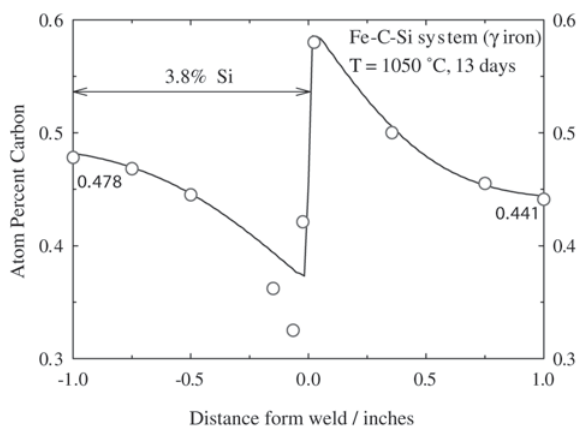
Figure 17. Simulation (solid line) of Darken’s 47 experiment dem- onstrating uphill diffusion of carbon in γ iron at 1050 °C using a jump frequency model for carbon that is a function of the silicon = (16X + 1) 8 × 109, Γ = Γ = 10 6 sec -1 . The concentration, Γ C Si Fe Si open circles represent concentrations from Darken’s experiment. The simulated concentration profile was obtained by multiplying the normalized concentration profile (512 iterations) with the square root of the annealing time (13